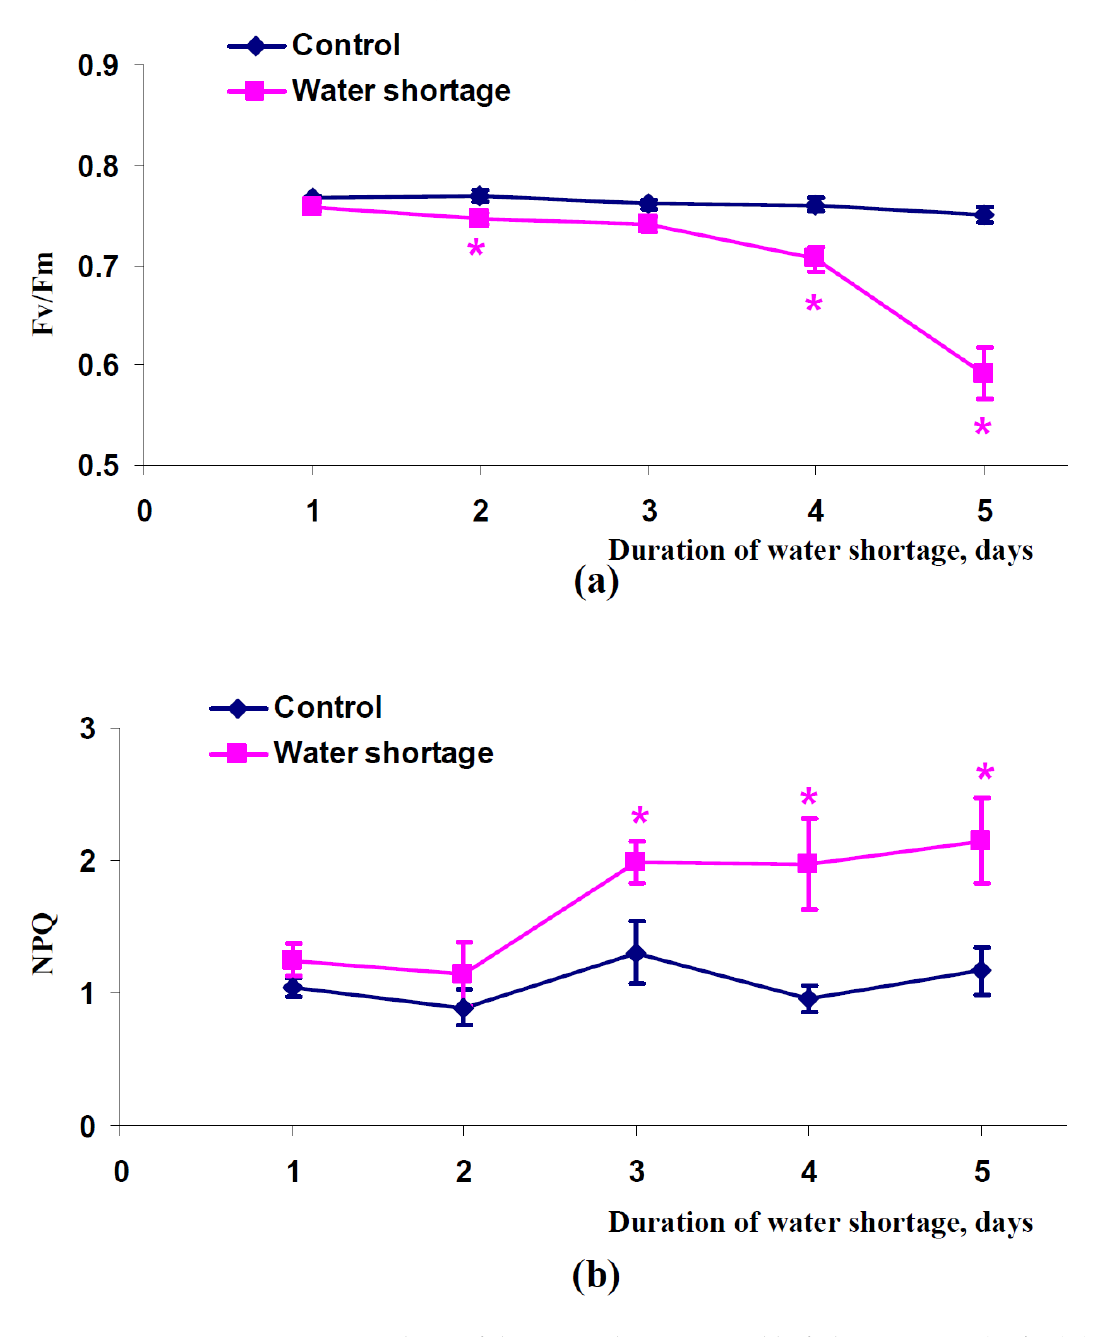
Figure 2. Dependence of the maximal quantum yield of photosystem II (Fv/Fm) ( a ) and non-photochemical quenching of chlorophyll fluorescence (NPQ) ( b ) in spatially fixed leaves of pea plants on duration of water shortage ( n = 5–6). *, difference between experimental and control parameters was significant ( p < 0.05).